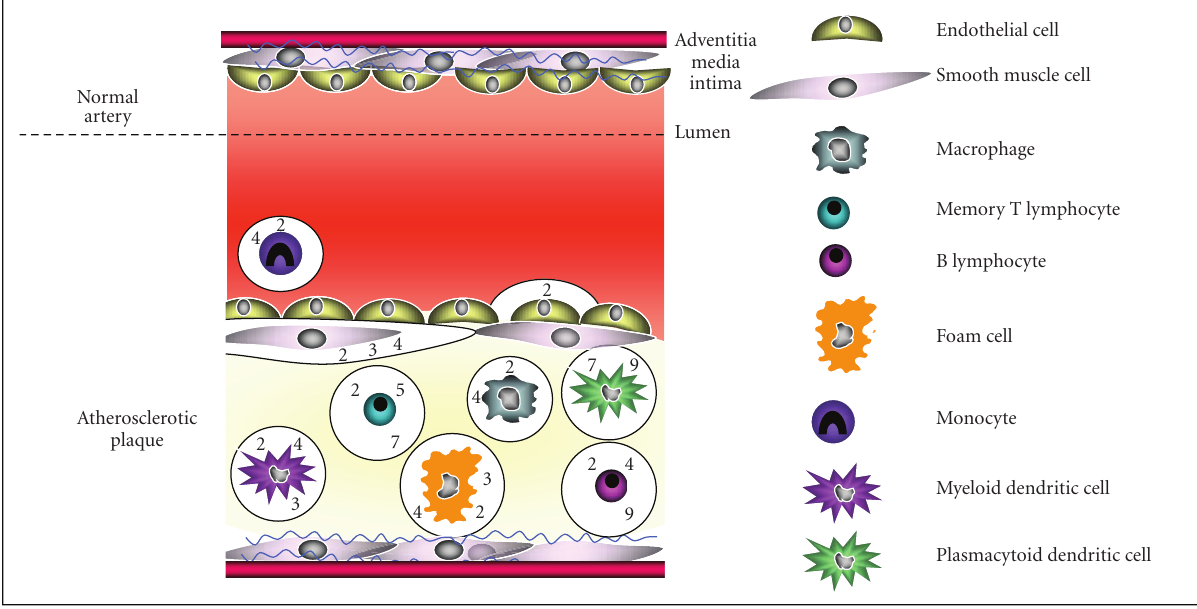
Figure 1: Toll-like receptor expression in atherosclerotic lesions is cell-type specific. Endothelial cell activation leads to increased expression of adhesion molecules, promoting the infiltration of monocytes into the subendothelial space. Recruited monocytes di ff erentiate into macrophages, ingest lipid and become foam cells that are retained within the lesion, promoting plaque growth. Smooth muscle cells proliferate and migrate into the intima where they form a fibrous plaque over the necrotic core of the lesion. In addition, myleloid dendritic cells, plasmacytoid dendritic cells and lymphocytes are observed in lesions. Both immune and resident vascular cells in atherosclerotic arteries express a variety of toll-like receptors or increase their expression during disease development. Each cell type expresses a specific combination which might dictate its ability to respond to exogenous or endogenous ligands and the consequences of such stimulation. Ligation of toll-like receptors on cells within atherosclerotic plaques can lead to numerous downstream e ff ects including; promoting monocyte recruitment, activation of plaque cells, induction of foam cell formation and activation of adaptive immune responses, which can all a ff ect lesion